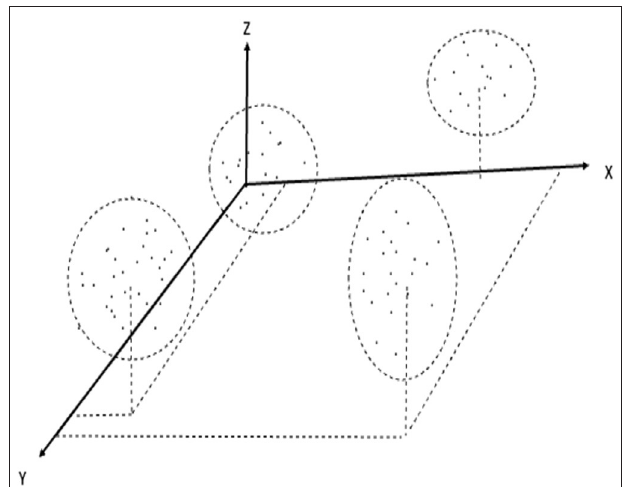
FIGURE 12 | Example of